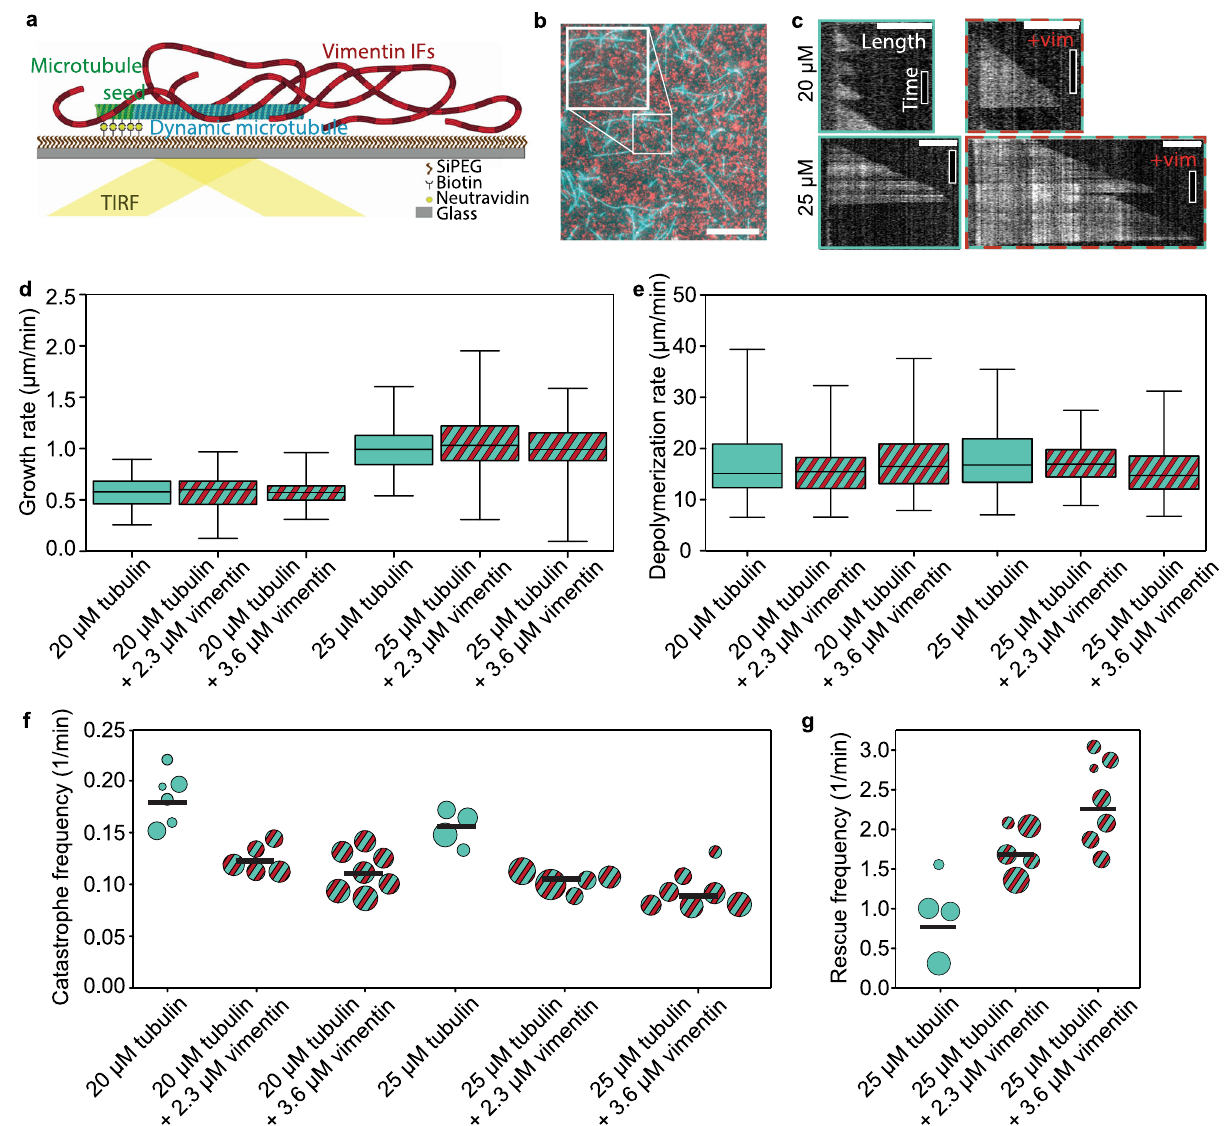
Fig. 1 Vimentin IFs stabilize dynamic microtubules. a Illustration of the experimental setup. We attached microtubule seeds (green) to a biotin- polyethylene glycol-silane (biotin-SiPEG) coated cover glass. Dynamic microtubules (cyan) grew from the seeds. Vimentin IFs (red) formed an entangled, fl uctuating network. We imaged microtubules by TIRF microscopy. b Fluorescence micrograph of microtubules (cyan) embedded in a vimentin IF network (red). The inset shows the enlarged detail. Scale bar: 10 μ m. c Example kymographs of microtubules growing at 20 or 25 μ M tubulin in the presence ( + vim; 2.3 μ M) or absence of vimentin. Scale bars: 3 μ m and 5 min. d , e Vimentin does not affect the microtubule growth and depolymerization rates, irrespective of the tubulin concentration. Cyan boxplots represent experiments with tubulin only; cyan- and red-striped boxplots illustrate experiments with tubulin and vimentin. Boxplots include the median as the center line, the 25th and 75th percentiles as box limits, and the entire data range as whiskers. In ( d ), for 20 μ M tubulin and in the absence of vimentin, the boxplot represents the data from N = 6 samples and n = 106 growth events (we de fi ne a growth event as the new outgrowth of a microtubule from the seed or after a rescue event). For the other boxplots, from left to right, N = 5, 7, 4, 5, and 7, respectively, and n = 163, 282, 113, 160, and 218, respectively. In ( e ), from left to right, the boxplots represent the data from n = 58, 140, 228, 112, 133, and 165 depolymerization events, respectively. f The catastrophe frequency of the microtubules decreases in the presence of vimentin. Each circle represents an experiment including multiple microtubules. The area of the circle scales with the total summed microtubule growth time of the respective experiment. Black bars indicate the weighted mean. From left to right, the plot represents the data from a total of 805, 1469, 2692, 1142, 2203, and 2232 min of growth time, respectively. g Vimentin enhances the microtubule rescue frequency. Each circle represents an experiment including multiple microtubules. The area of the circle scales with the total microtubule depolymerization time. From left to right, the plot represents the data from a total of 51, 71, and 52 min depolymerization time, respectively. All tubulin and vimentin concentrations are input concentrations. Source data are provided as a Source Data fi